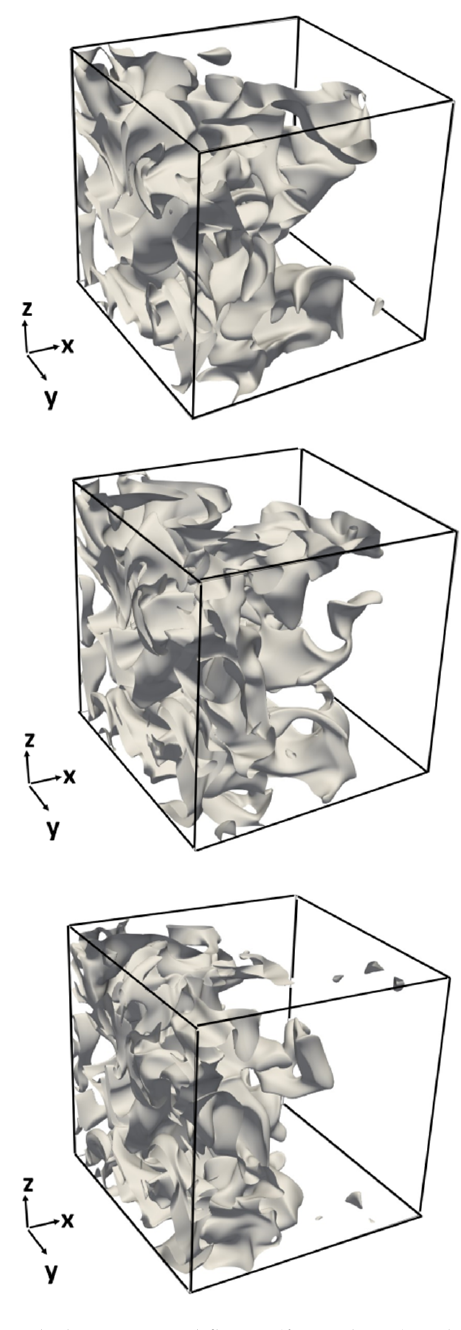
Figure 2. Instantaneous views of the c = 0.8 isosurface for statistically planar turbulent premixed flames (first column) and homogeneous MILD combustion cases (second column) for initial u (cid:48) / S L = 4.0,6.0 and 8.0 (1st–3rd rows).